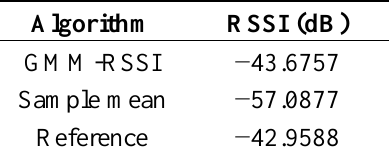
Table 1. Experimental result